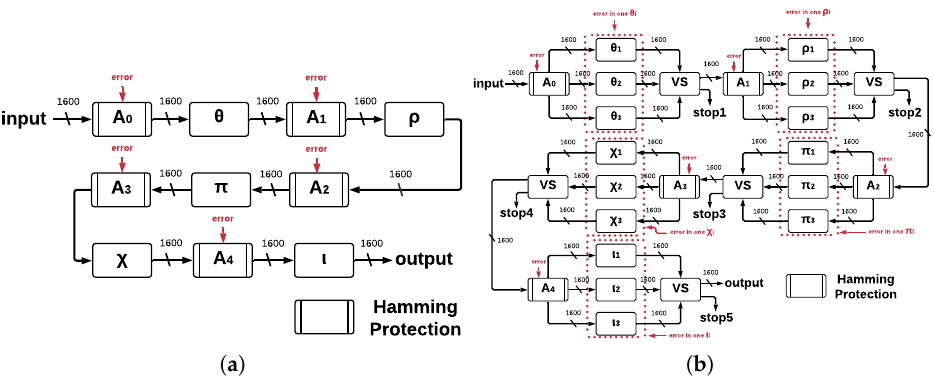
Figure 10. Error injection for ArchHC and ArchTMR_HC. ( a ) Error injection in ArchHC at Round level. ( b ) Error injection in ArchTMR_HC at Round